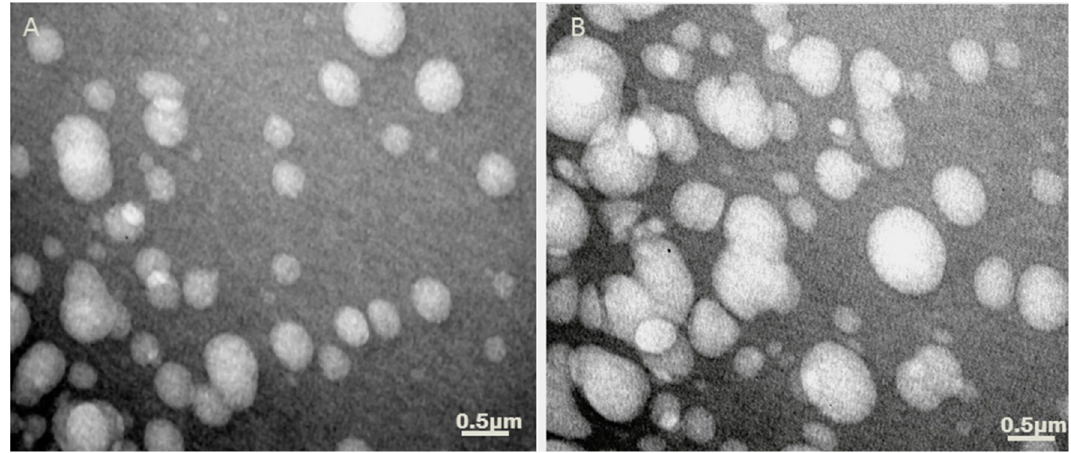
Figure 1. TEM of cationic liposomes. The liposomes were prepared by the film hydration method and fixed with Uranyl for morphological analyses. The micrographs show unilamellar liposomes of DDA/TDB alone ( A ); DDA/TDB plus P10 ( B ).